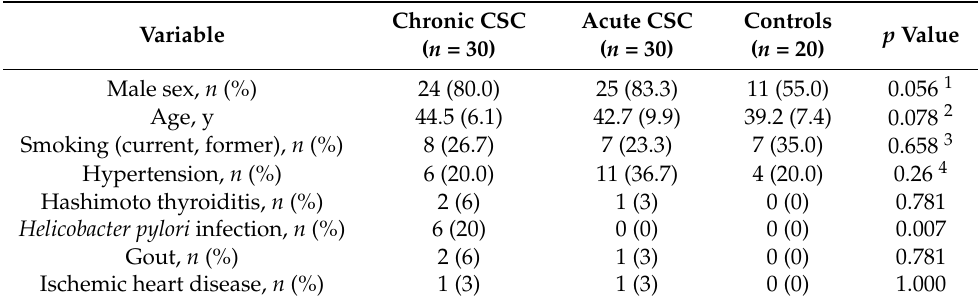
Table 1. Demographic and clinical characteristics of patients with acute and chronic central serous chorioretinopathy as well as